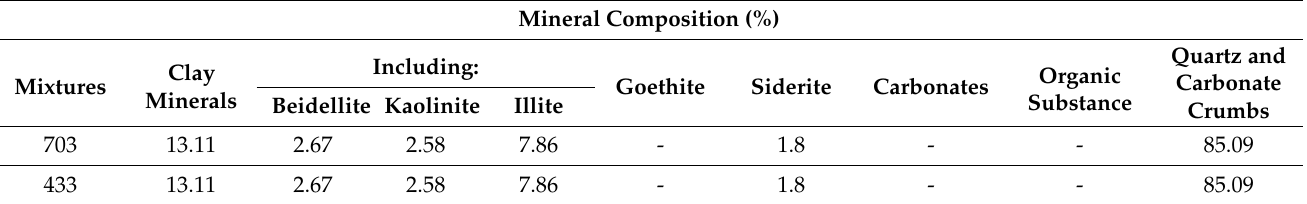
Table 3. Mineral composition of soil mixtures used in tests.